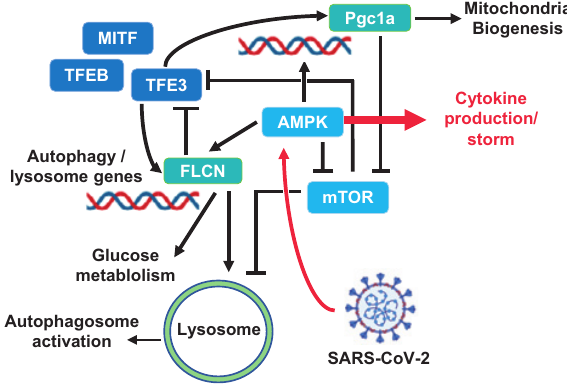
F i g ure 3. Schematic representation of SARS-Co V -2-ind u ced c y tokine prod u ction and related meta- bolic path w a y